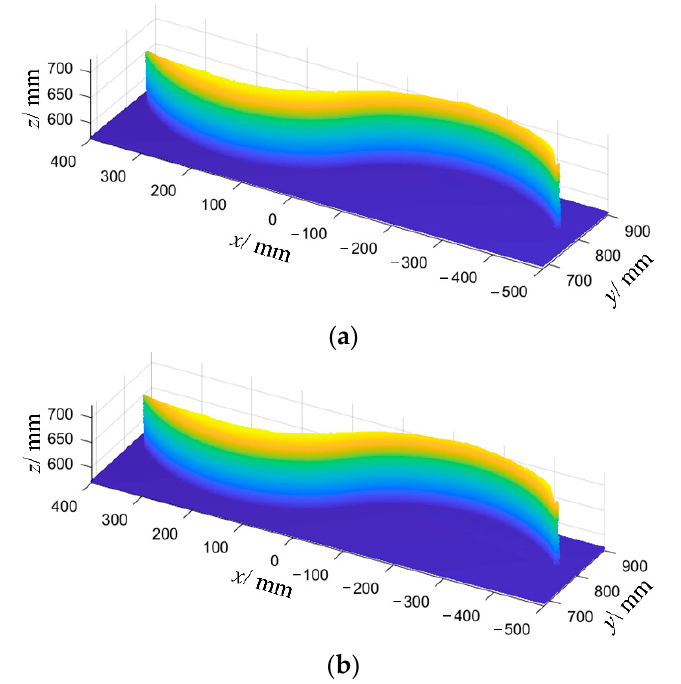
Figure 22. The point cloud data of the weldment under the welding sequence “ ③④②⑤①⑥ ”: ( a ) before welding; ( b ) after welding.